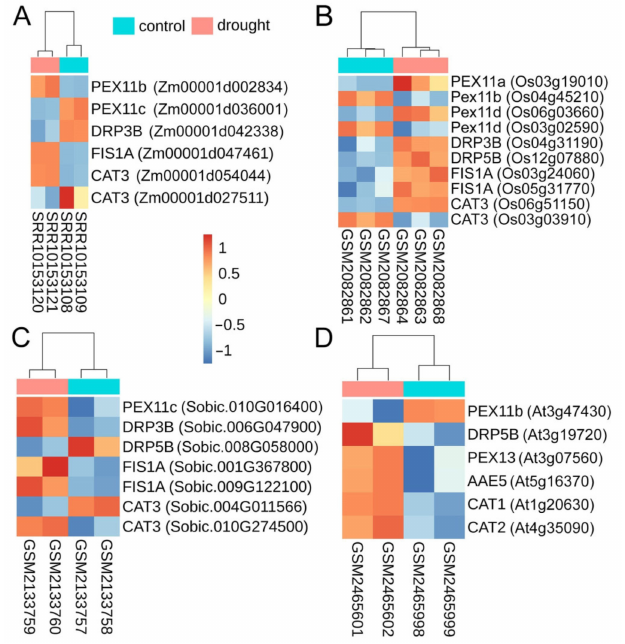
Figure 6. Expression of peroxisome biogenesis genes in response to drought stress. ( A – D ), Heatmaps of peroxisome fission genes that are differentially expressed in response to drought stress in Z. mays ( A ), O. sativa ( B ), S. bicolor ( C ), A. thaliana ( D ). The figure was generated with the R pheatmap package using VarianceStabilizedTransformation-vst() function built-in DESEq2 package. Vst values were represented based on the z-score transformation. Samples were clustered according to Pearson correlation analysis. Loci name of orthologs that were mapped to peroxisome fission genes are included next to the gene